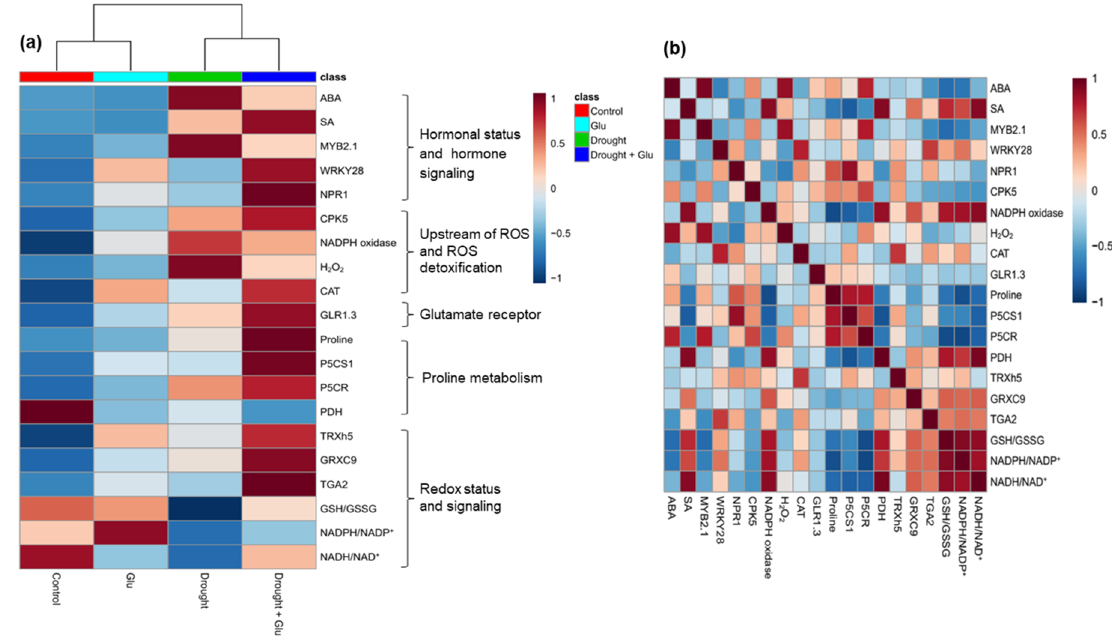
Figure 7. Heatmap analysis of the treatment effect and correlations among the variables measured at day 15 (after 15 d of drought, including 10 d of glutamate application). ( a ) Heatmap comparing the changes in the identified metabolites or gene expression levels in the leaves of control or glutamate (Glu)-treated plants under well-watered or drought-stressed conditions. The normalization procedure consisted of mean row-centering with color scales. ( b ) Heatmap showing the correlations among the identified metabolites or gene expression levels. Correlations coefficients were calculated based on Pearson’s correlation. Red indicates a positive effect, whereas blue indicates a negative effect. Color intensity is proportional to the correlation coefficients.